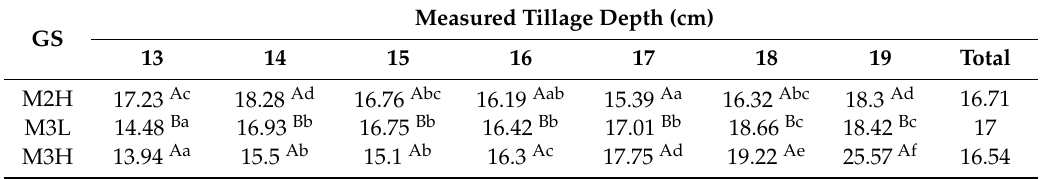
Table 6. Mean slip ratio (%) according to tillage depth and gear selection (GS).